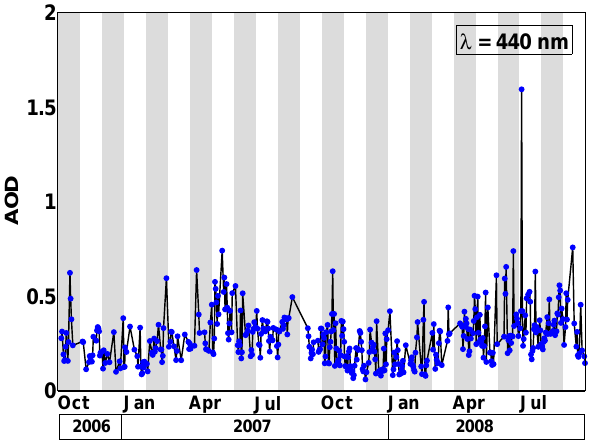
Fig. 3. Temporal evolution of AOD (440nm), monthly averages in Zanjan for the period of October 2006 to September 2008, the IASBS site.